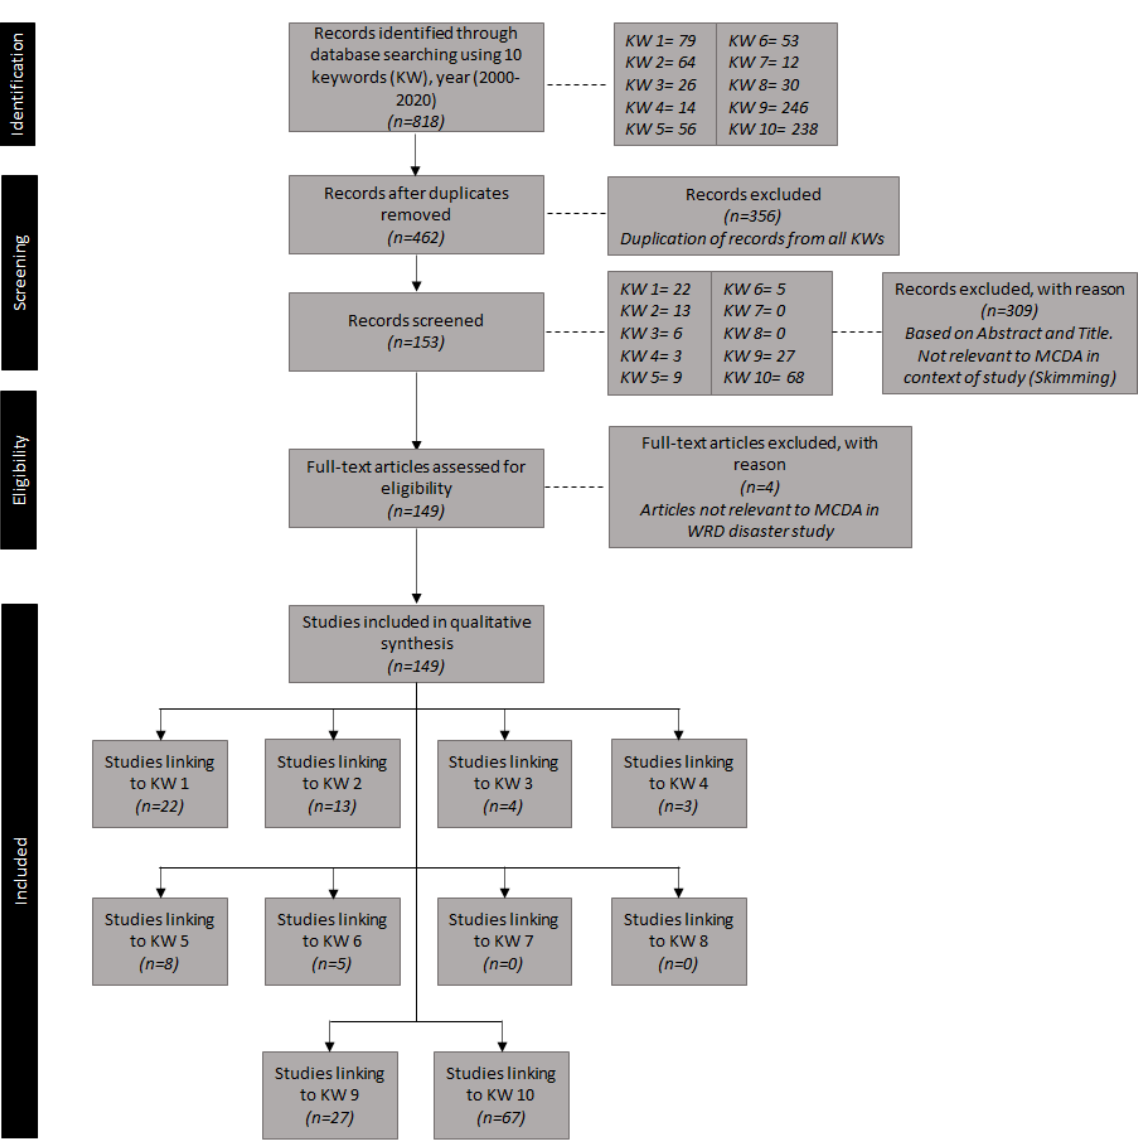
Figure 1. PRISMA flow diagram for the selection of eligible studies.